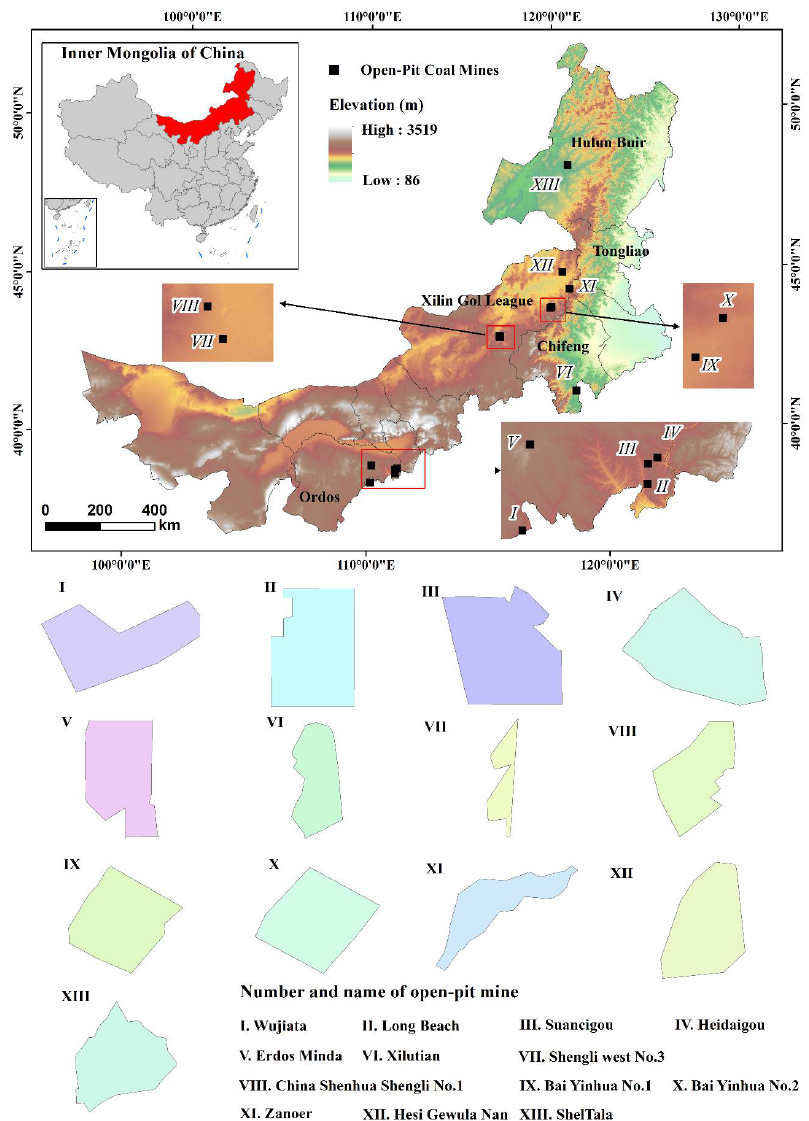
Figure 1. Locations and outlines of open-pit coal mines investigated in this study.